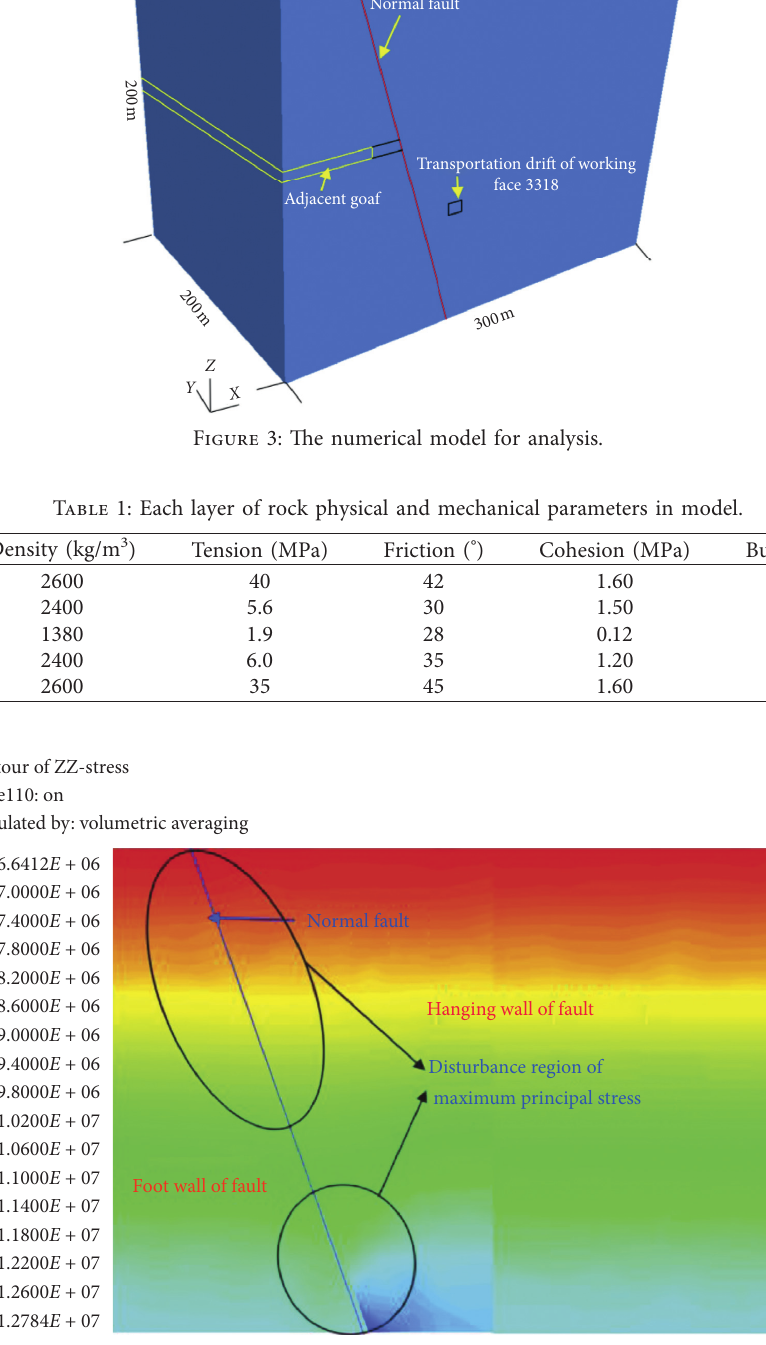
Figure 4: Vertical stress distribution law of rock mass near the fault area.